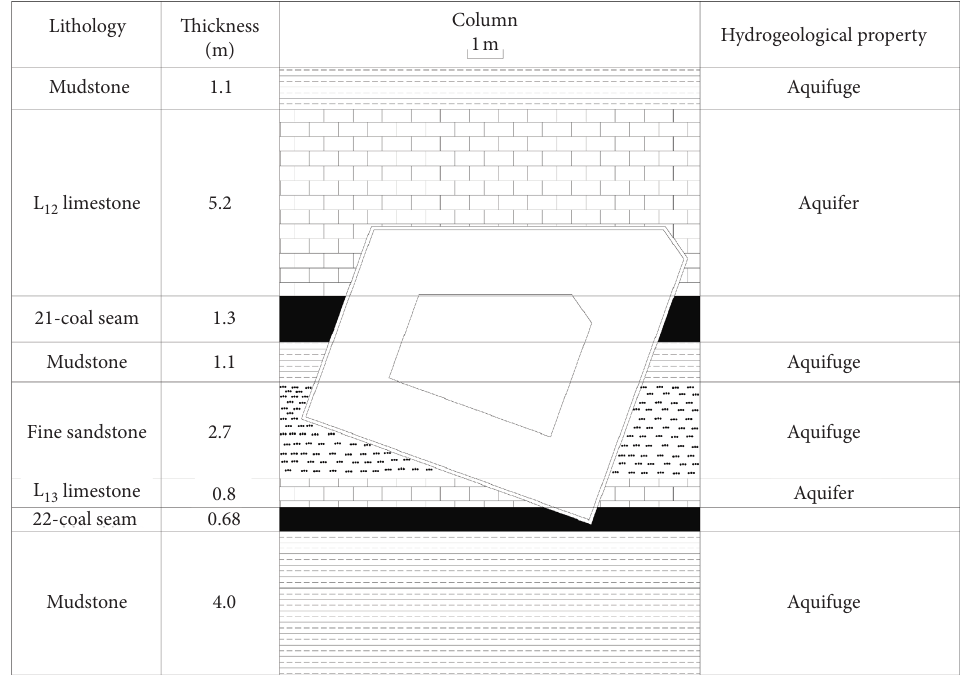
Figure 2: Schematic diagram of Panel No. 21102 and surrounding rock in Sanhejian coal